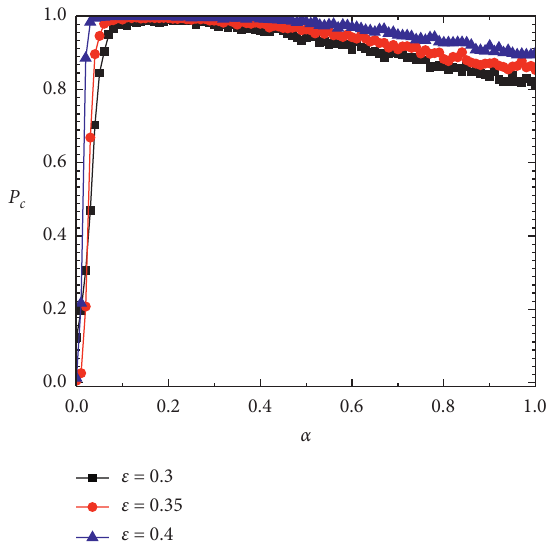
Figure 2: The probability of complete consensus P α at ε � 0 . 3 , 0 . 35, and 0.4. The optimization of P c by α could be obviously found. Figure 1: The probability of complete consensus P c as a function of , at 2